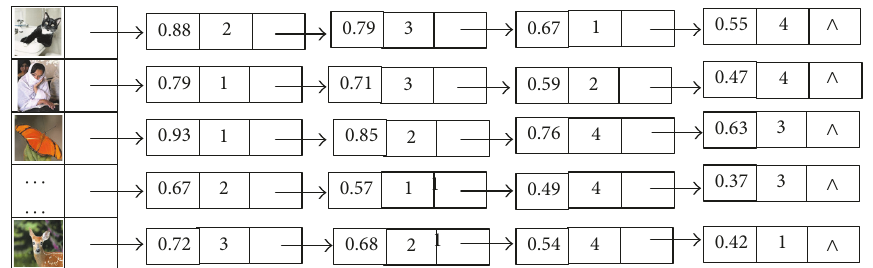
Figure 7: Images and their sort